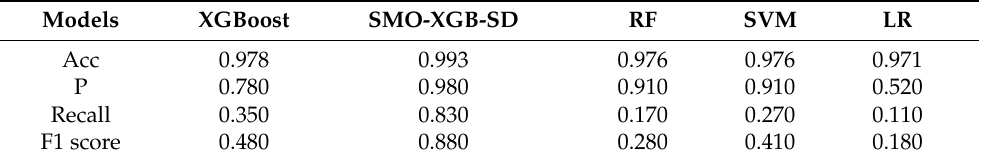
Table 4. Comparison results of SMO-XGB-SD, XGBoost, RF, SVM, and LR.